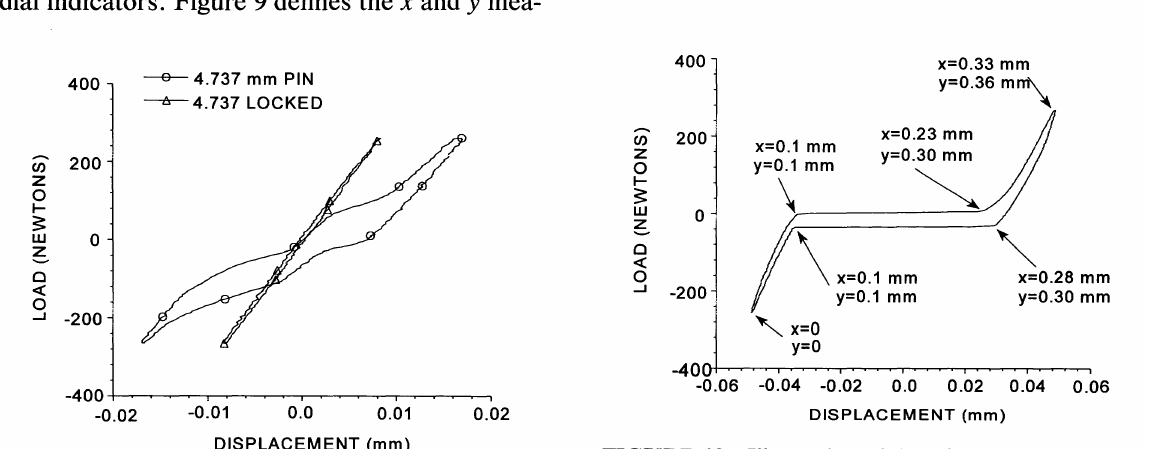
FIGURE 8 Plot of hysteresis test for 4.737-mm pin.